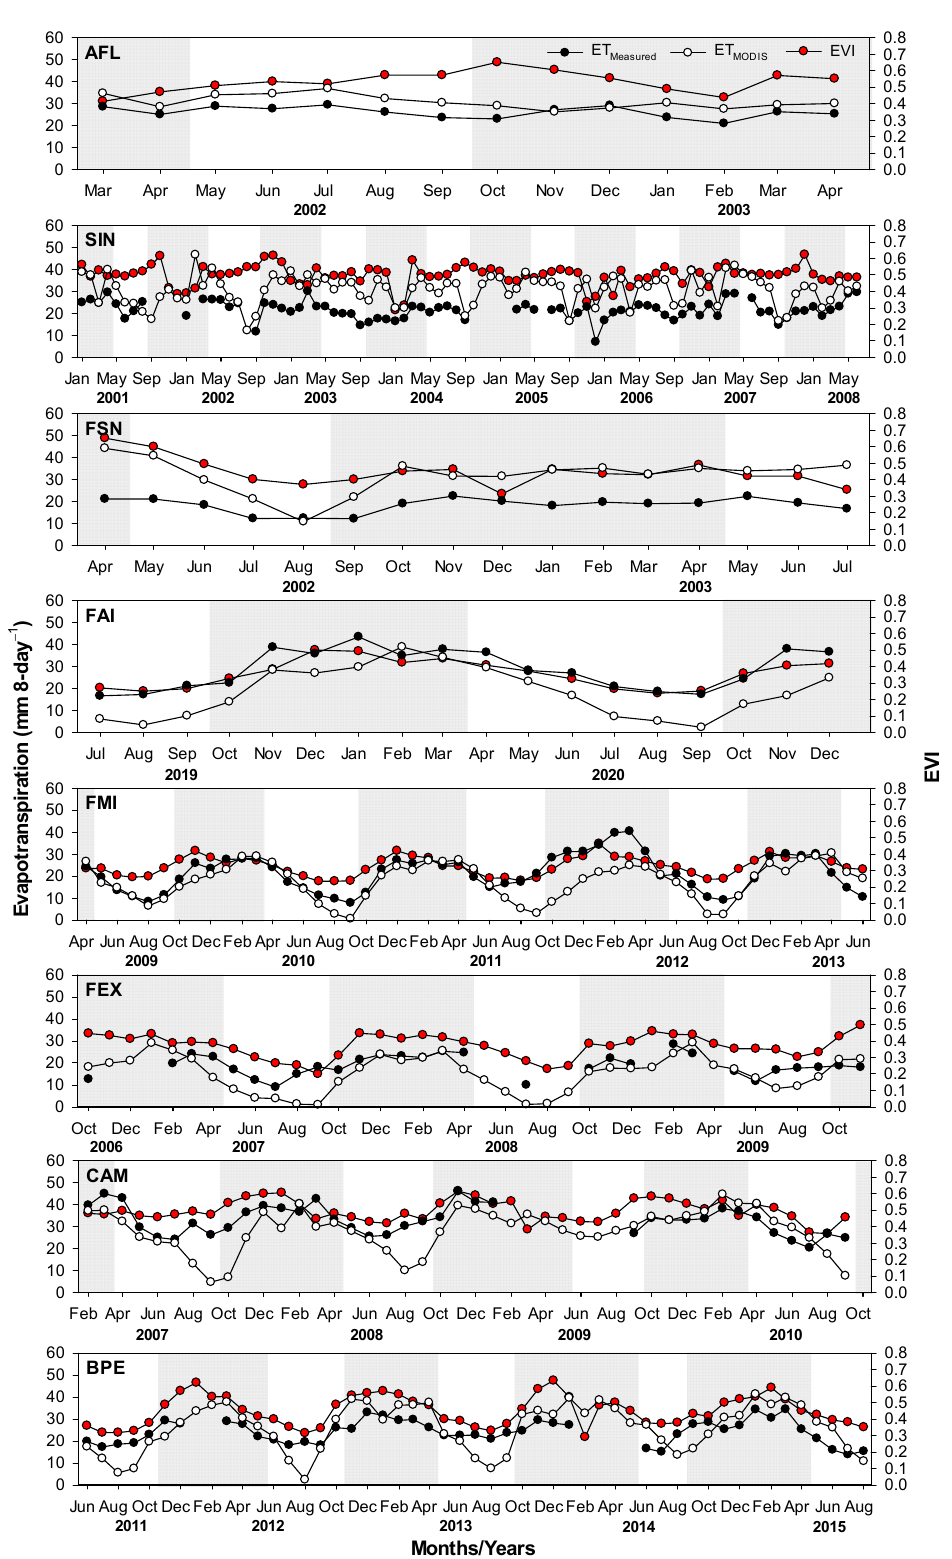
Figure 6. Monthly average of measured (ET Measured ) (black circles) and estimated (ET MODIS ) (white circles) evapotranspiration of cumulative 8 days (mm 8-day − 1 ), respectively, and 16-day average MODIS-based enhanced vegetation index (EVI) (red circles) in the experimental sites located in the Amazon (AFL, SIN and FSN), Cerrado (FAI, FMI and FEX), and Pantanal (CAM and BPE). The wet season over each site was highlighted with a gray vertical shaded background. A threshold of more than 100 mm of the monthly precipitation was used to identify the dry season, based on [62].